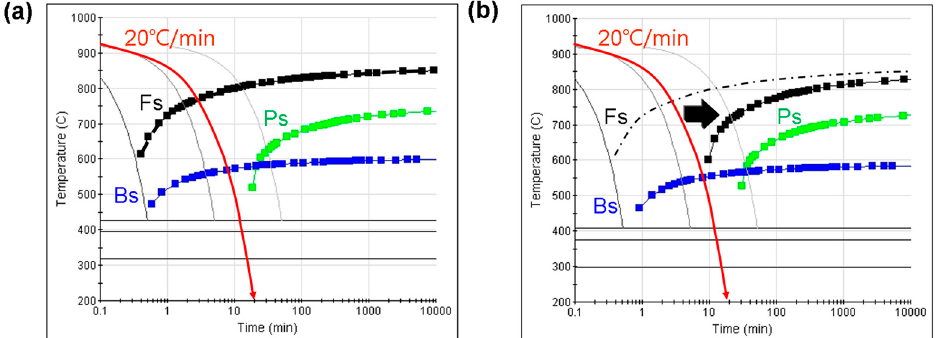
Figure 2. Schematic of continuous cooling transformation (CCT) diagrams for steel calculated from the JMatPro software: ( a ) composition of model A; ( b ) prediction composition of advanced steel.